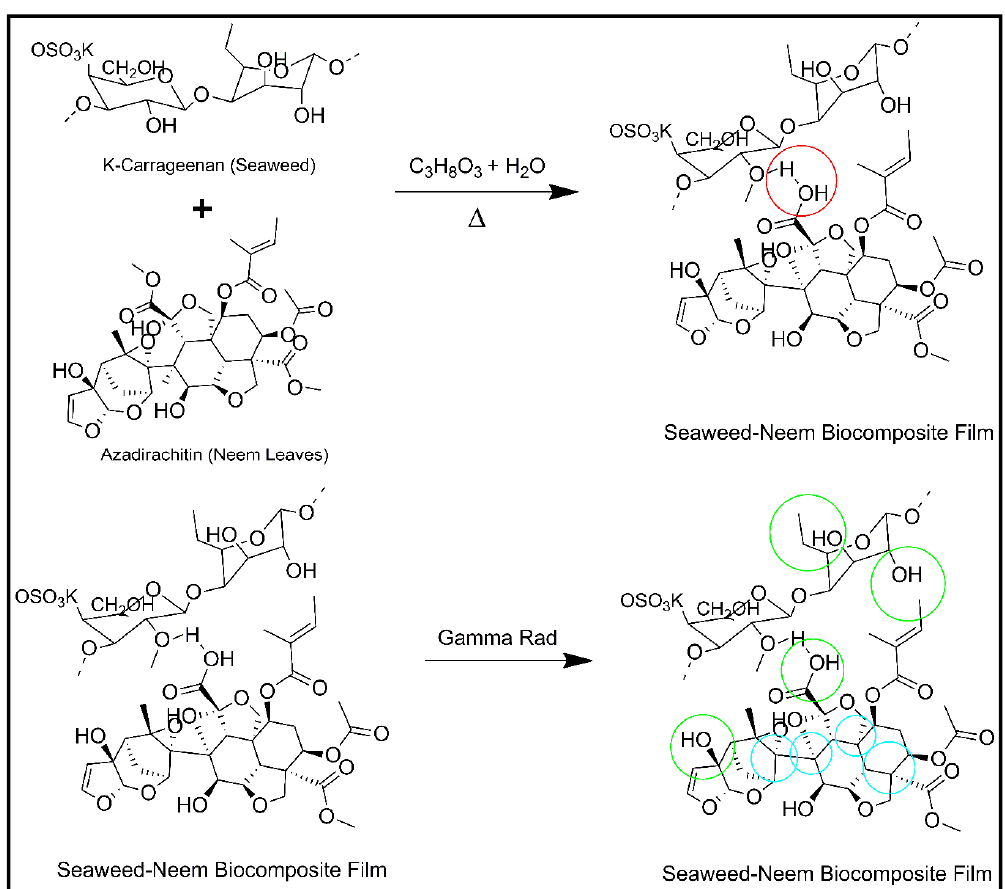
Figure 6. Proposed mechanism of seaweed-neem biocomposite film irradiated with gamma radiation. The blue circle represents C–Tertiary bond breakage, the green circle represents C–OH bond breakage and red circle represents H- bond.